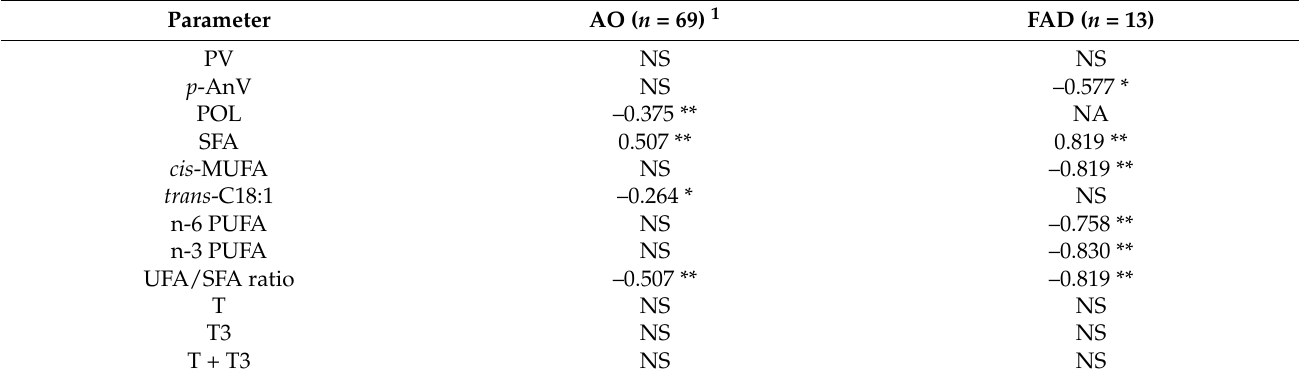
Table 3. Spearman’s correlation coefficients (Spearman’s Rho) between the induction time (IT) and the main variables determined in acid oils (AO) from chemical refining and in fatty acid distillates (FAD) from physical refining.